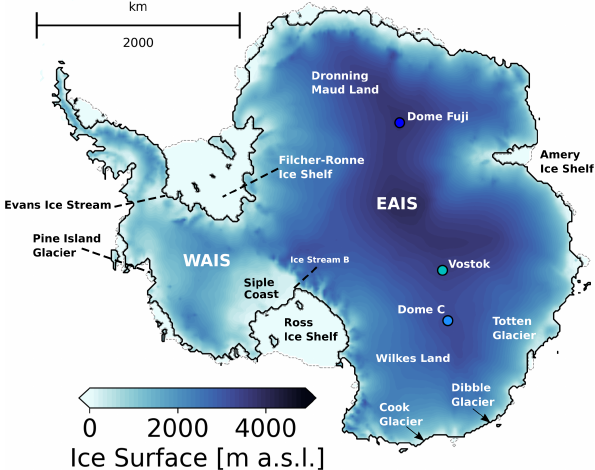
Figure 1. Surface topography of the AIS at the start of our core experiments (425ka), based on a calibration against Bedmap2, (Fretwell et al., 2013, see Sect. 2.1). Locations mentioned in the text are showcased, including the drilling sites of the ice cores used in this study